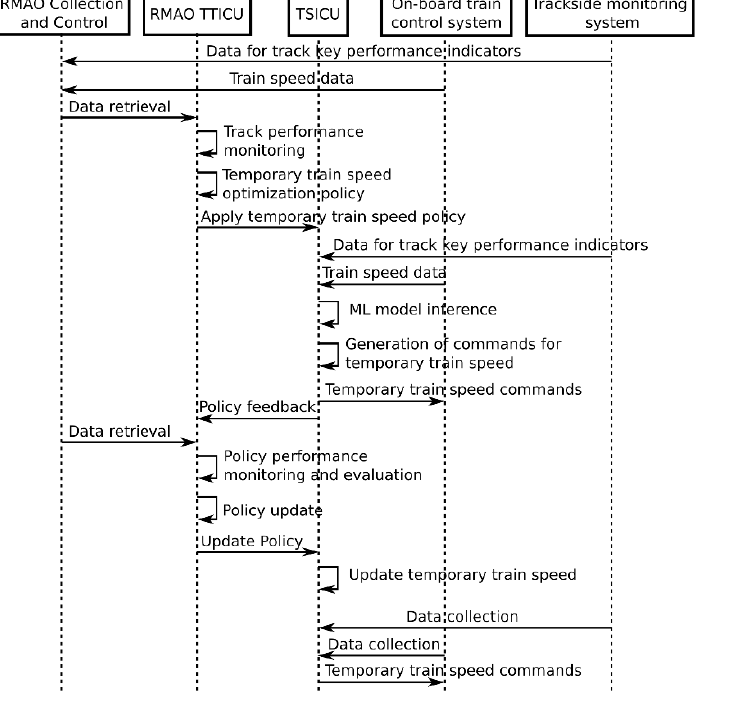
Figure 3. Train speed policy generation, policy enforcement, and policy performance evaluation.